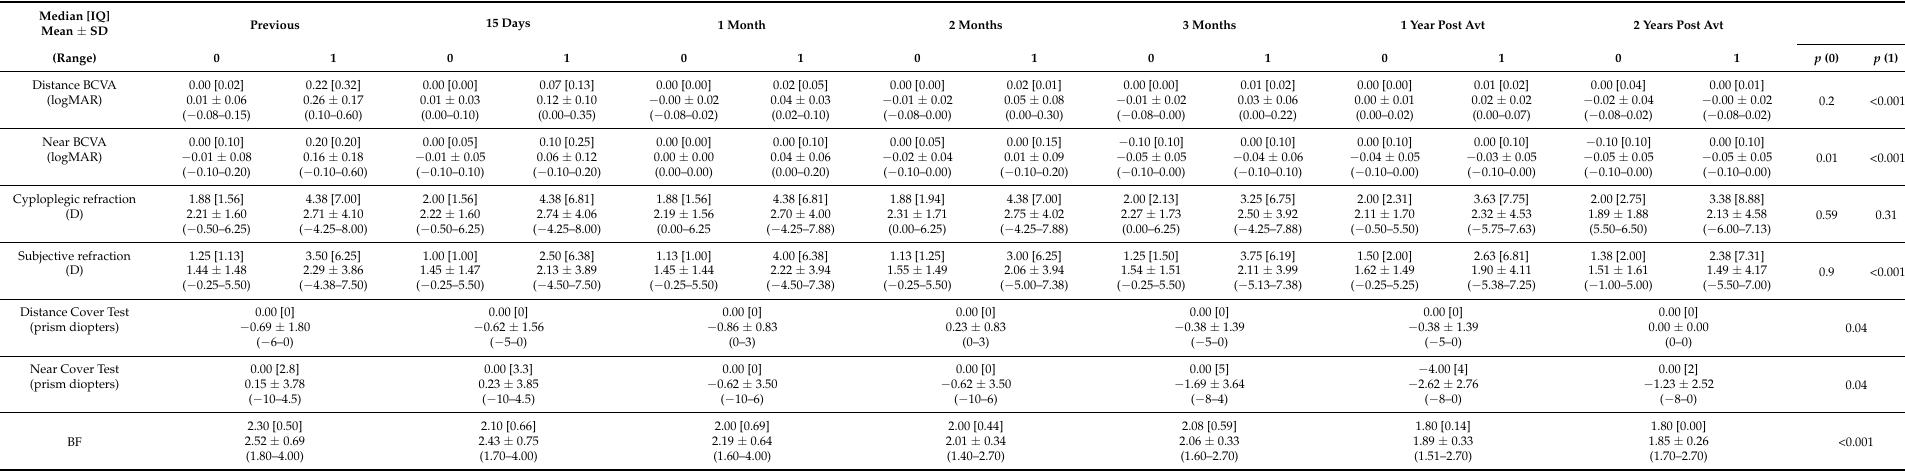
Table 3. Median [range], mean ± SD and (min-max) of the different variables evaluated in non-amblyopic (0) and amblyopic (1) eyes in the anisometropic amblyopia group from the previous visit to 15 days, 30 days, 60 days and 90 days of treatment. Similarly, data of the one and two-year follow-up after completion of treatment were also